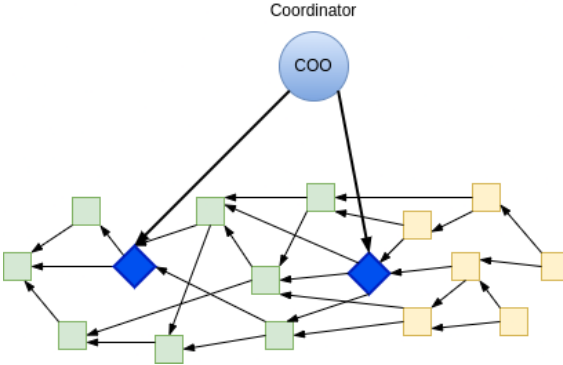
Figure 4. Transactions in IOTA ledger confirmed by